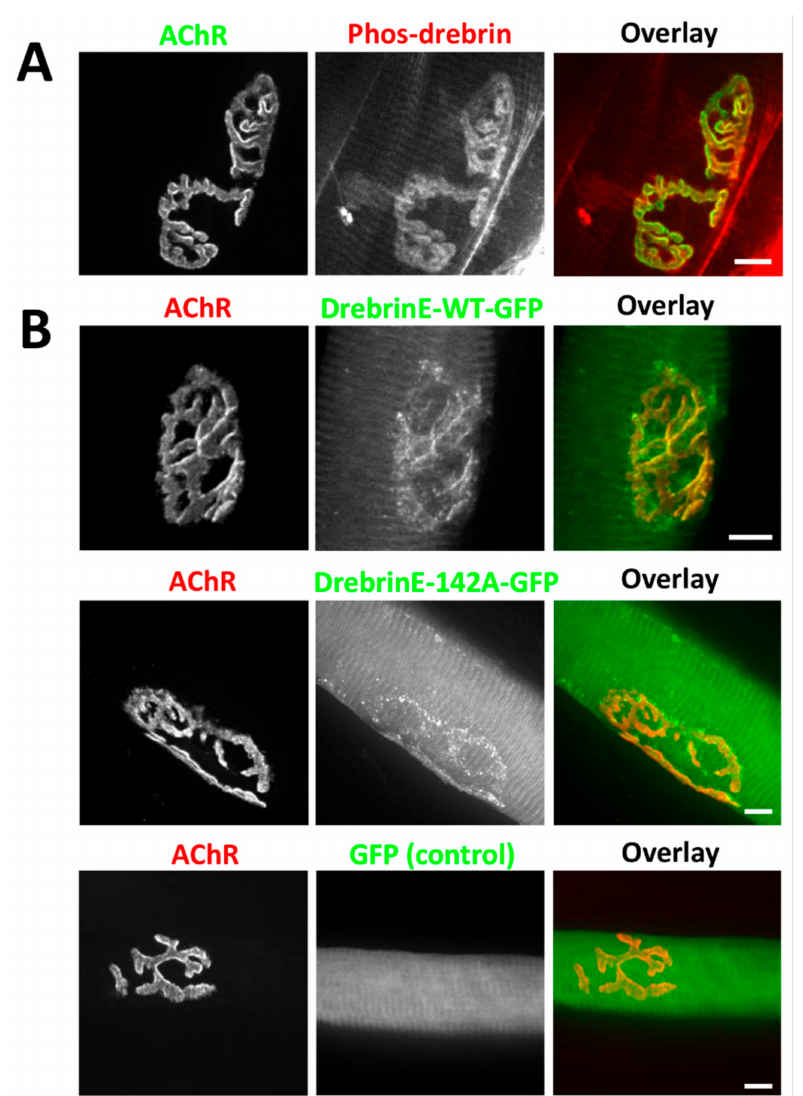
Figure 2. Phosphorylation does not affect drebrin localization at neuromuscular junctions (NMJs). ( A ) Colocalization of endogenous drebrin phosphorylated at Ser142 (red) with BTX-labeled AChRs (green) in tibialis anterior muscle. ( B ) Localization of exogenous wild-type drebrin (DrebrinE-WT-GFP, green), and phospho-dead mutant at Ser142 (DrebrinE-142A-GFP, green) overlaps with AChRs (red) at the NMJs of tibialis anterior muscle. Enhanced green fluorescent protein (EGFP) concentration at the NMJ (control) was not detected. Scale bars—10 µ